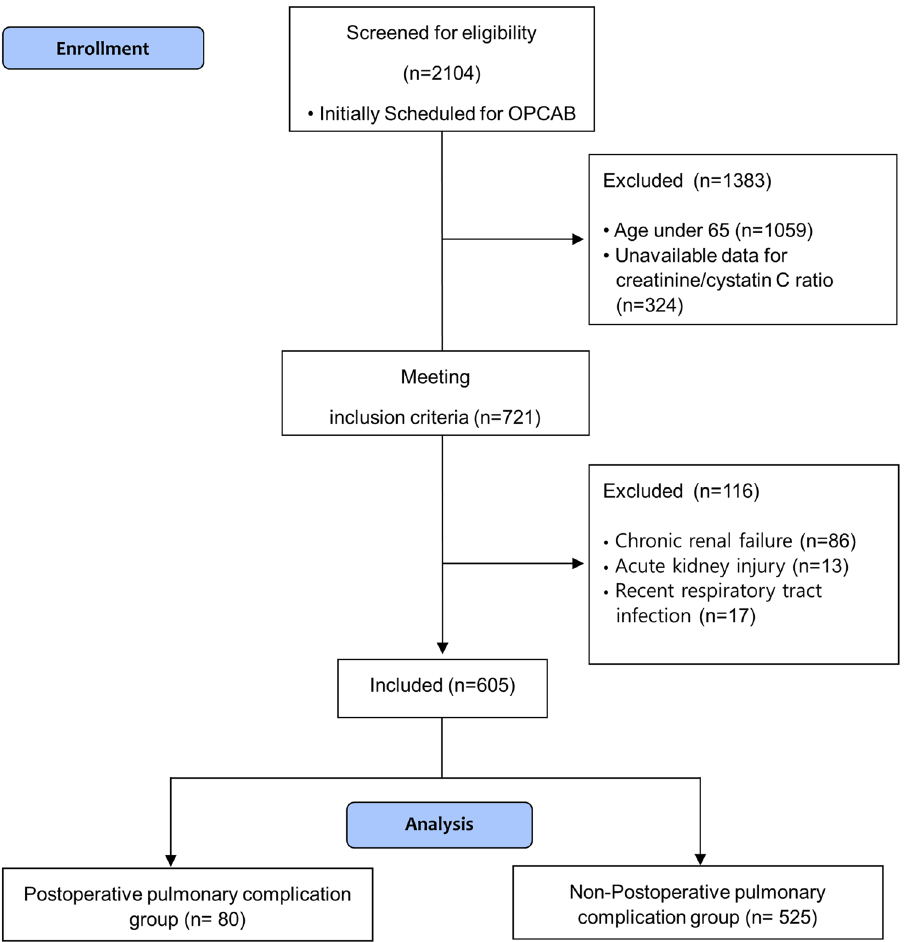
Figure 1. Flow chart of patient enrolment. Among the 2104 patients scheduled for off-pump coronary artery bypass graft surgery from January 2010 to December 2019, 1383 did not meet the inclusion criteria (1059 patients were < 65 years old, and 324 did not have serum cystatin C and creatinine test results that were obtained within 1 week before surgery). Among the remaining 721 patients, 116 met the exclusion criteria (86